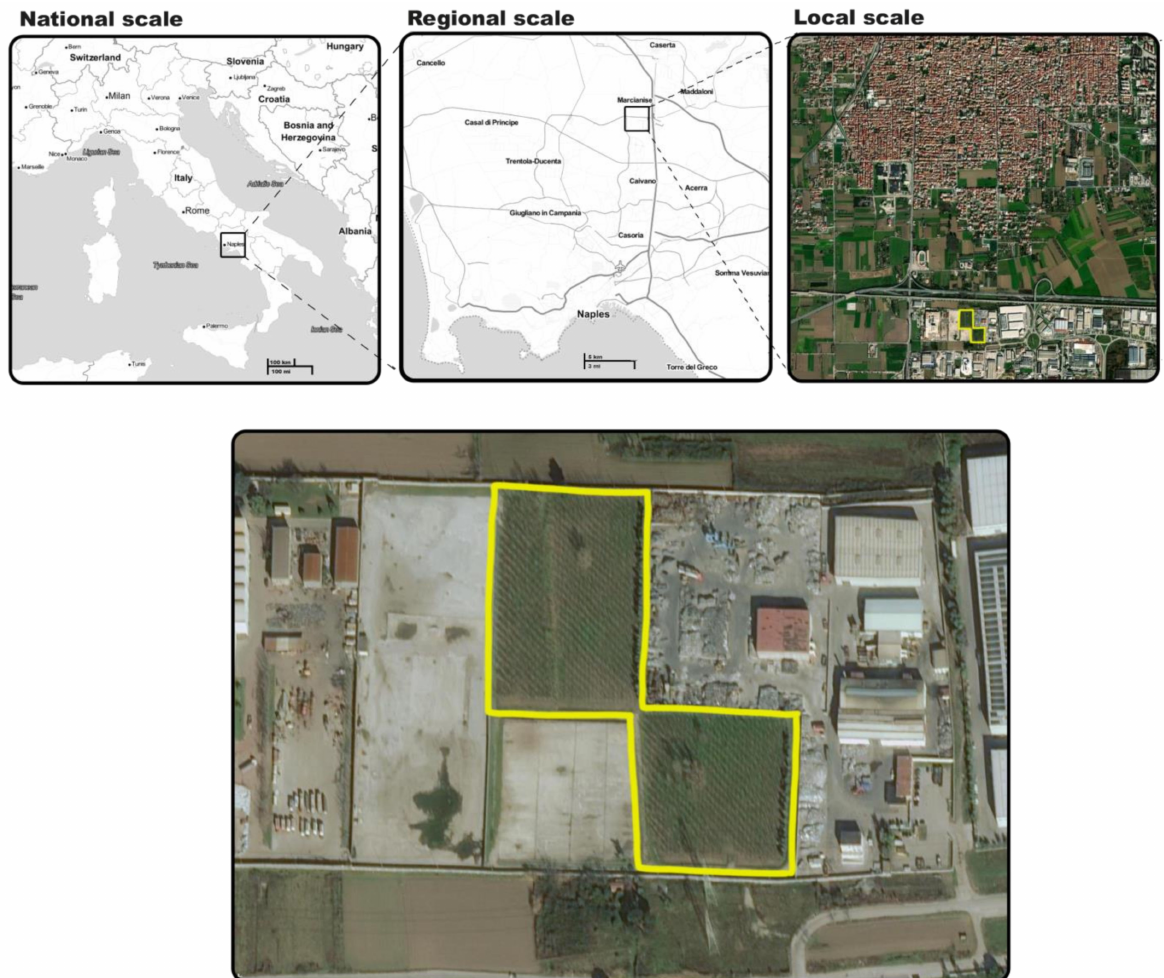
Figure 1. Sketch map of the study site at national, regional, local and field